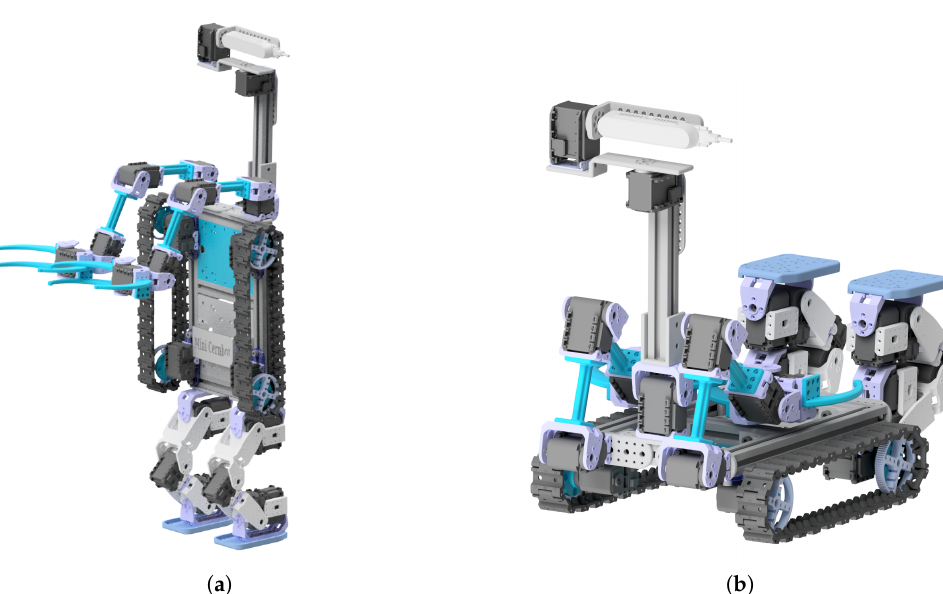
Figure 30. Transformer design that enables the robot to have two distinct configurations. ( a ) Trans- former configuration to manipulate a target, ( b ) configuration to explore the environment 4.1.5. High-School Student Medical Design to Reduce the Spread of Covid-19